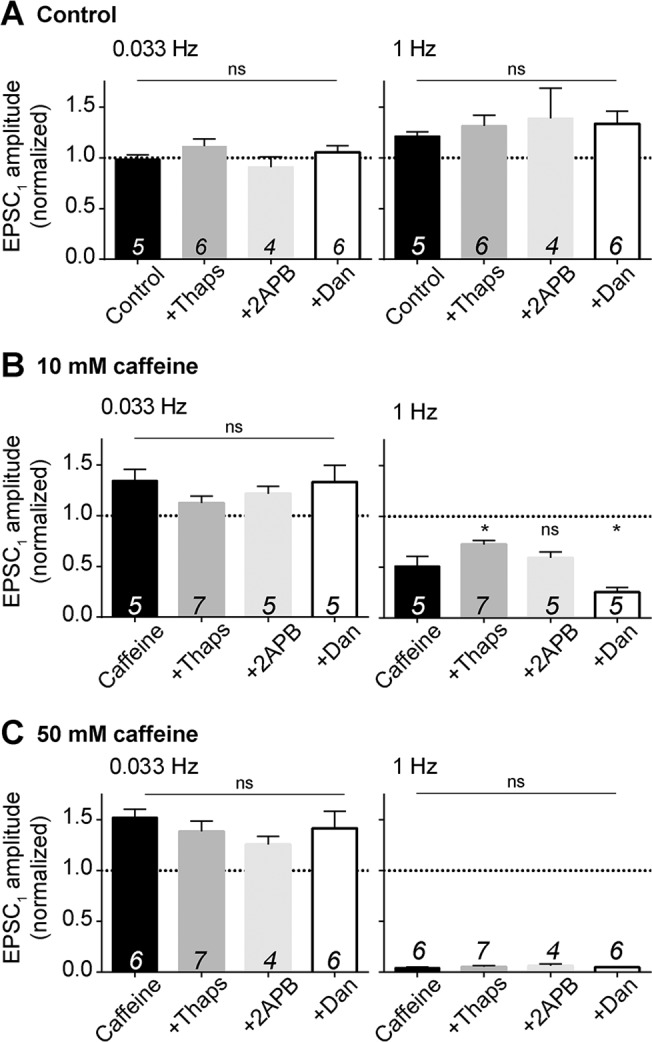
Modulation of calcium release from internal stores.A) Mean EPSC1 amplitude following incubation in the absence (control) and presence of the stated inhibitors (Thaps: thapsigargin, 2 μM; 2-APB, 10 μM; Dan: dantrolene, 20 μM) for 20 minutes during 0.033 Hz stimulation (left panel) and a subsequent 5 minutes with 1 Hz stimulation (right panel). See Fig 5A for representative full time course. B) Mean EPSC1 amplitude in control cells, or cells pre-incubated for 10 minutes with the stated inhibitors, following addition of 10 mM caffeine for a further 10 min. Mean values are for EPSC1 amplitude after 10 min stimulation in the presence of caffeine at 0.033 Hz (left panel) and a further 5 min stimulation at 1 Hz (right panel). C) As B, for cells exposed to 50 mM caffeine. Numbers superimposed over each bar on the chart are number of cells per group. All data sets are the result of experiments using slices harvested from a minimum of 2 animals, with the exception of 10 mM caffeine plus dantrolene, which is from 1 animal. Statistical significance of differences in mean between control and inhibitors, or caffeine in the presence and absence of inhibitors, was tested for using one-way ANOVA followed by Dunnett's multiple comparisons test. *P <0.05; ns, P >0.05. Single sample t tests were used to compare caffeine data to their respective controls: control vs 50 mM at 0.033 Hz—P = 0.0003; control vs 50 mM at 1 Hz—P < 0.0001; control vs 10 mM at 0.033 Hz—P = 0.0158; control vs 10 mM at 1 Hz—P = 0.0001.